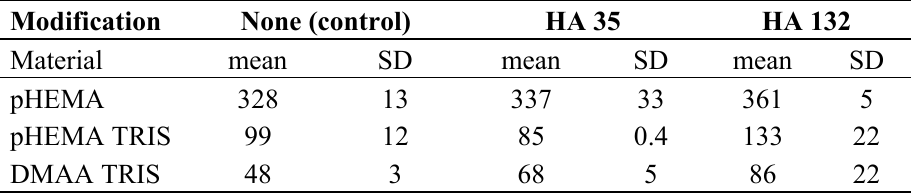
Table 1. Total mass (µg) of ciprofloxacin released from all model lens